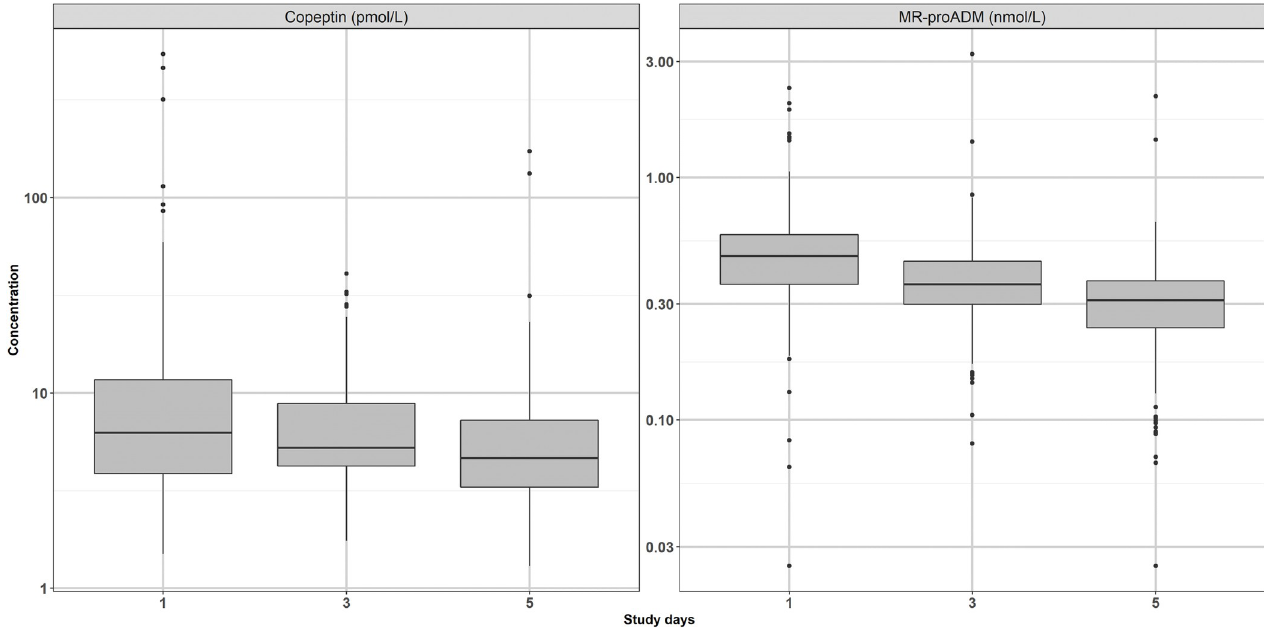
Fig 1. Copeptin and MR-proADM concentrations over the study period. Distribution and change in copeptin (pmol/L) and MR-proADM (nmol/L) concentrations for patients over 5 study days. Boxes represent the interquartile range (IQR). Solid lines are the median, 25th and 75th quantile and whiskers equal 25th quantile -1.5 IQR and 75th quantile +1.5 IQR.